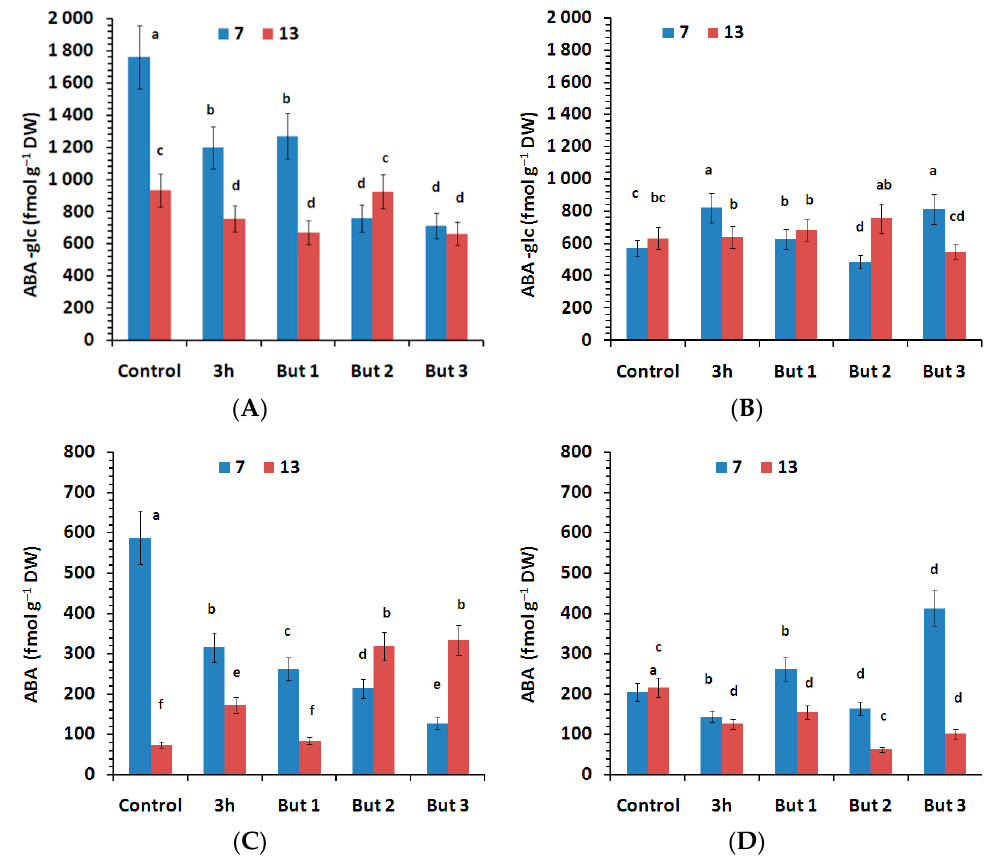
Figure 7. Content of inactivated form of ABA (ABA-glc) and active ABA measured in the seeds of two L. angustifolius cultivars (Lazur—( A , C ); Sethes Fruehe Rote—( B , D )) germinated at 7 °C or 13 °C in water (control), butenolide or hydroprimed in water for 3 h at 20 °C. But 1, But 2, But 3: 10 − 6 M, 10 − 5 M, 10 − 4 M butenolide concentrations. Different letters over error bars (±SE; n = 3) indicate significant differences (Duncan’s multiple range test, p < 0.05).